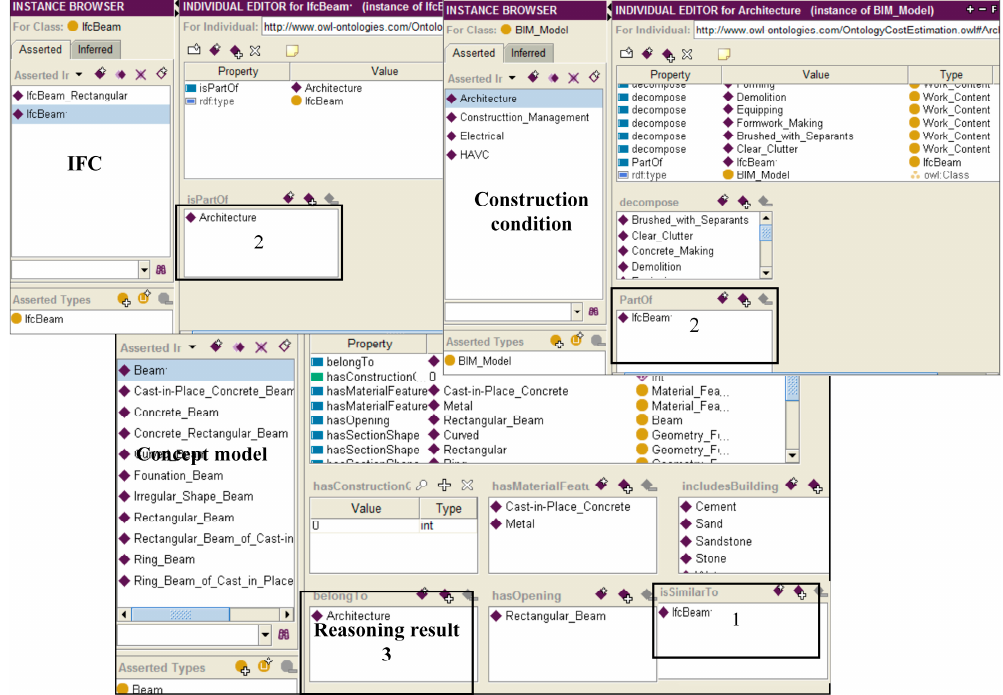
Figure 14. Reasoning result of the cost estimation ontology.